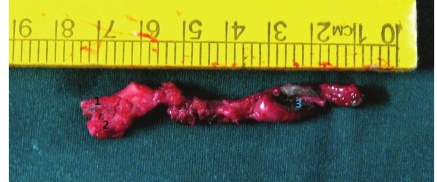
Figure 7: The entire fistula tract after excision. (1) End opening into the external auditory canal, (2) end going to postaural region, and (3) cervical opening with excised ulcer and scarred